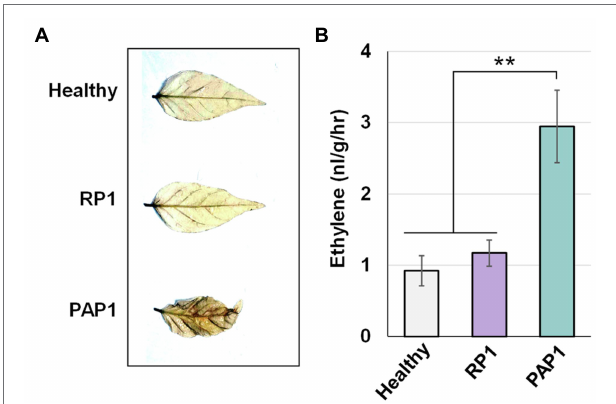
FIGURE 5 | Effect of BBWV2-PAP1 infection on reactive oxygen species (ROS) accumulation and ethylene production in pepper. (A) BBWV2-PAP1 infection increased ROS accumulation. Systemic leaves of pepper plants infected with BBWV2-PAP1 or RP1 were analyzed by 3,3 ' -diaminobenzidine (DAB) staining to visualize ROS accumulation. (B) BBWV2-PAP1 infection increased ethylene production. Ethylene emission from the upper uninoculated leaves of virus-infected and healthy plants was measured by gas chromatography. Means ± SD from three independent experiments are shown and each column represents one group with nine plants. Statistical analysis was performed using paired Student’s t -tests to detect significant differences analyses (** p <